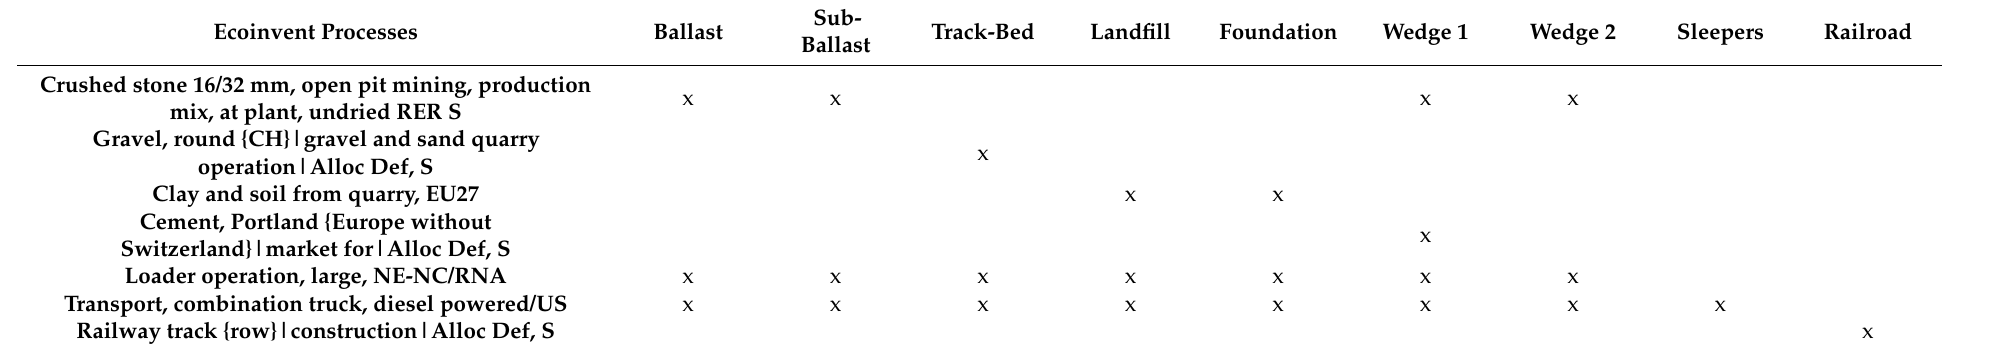
Table 4. Processes implemented to carry out the quantification of the environmental impact.